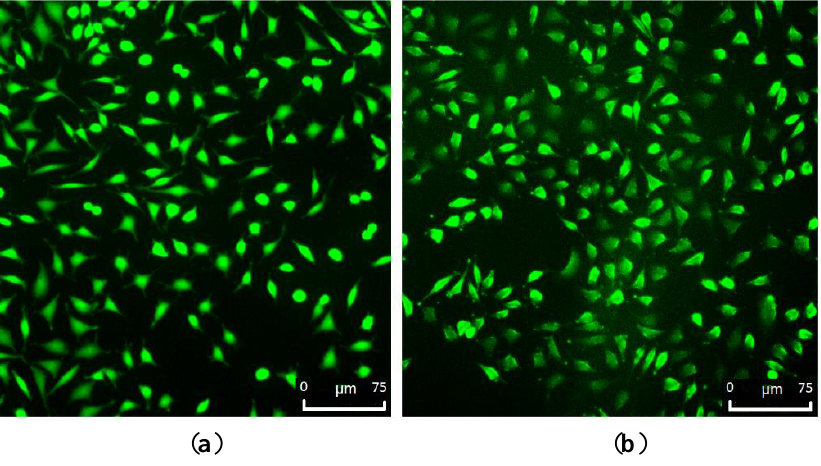
Figure 12. Fluorescence microscopy of stained L929 cells on — ( a ) TCP (control) and ( b ) hydrogel containing 1 wt.% MC (50 µl volume).